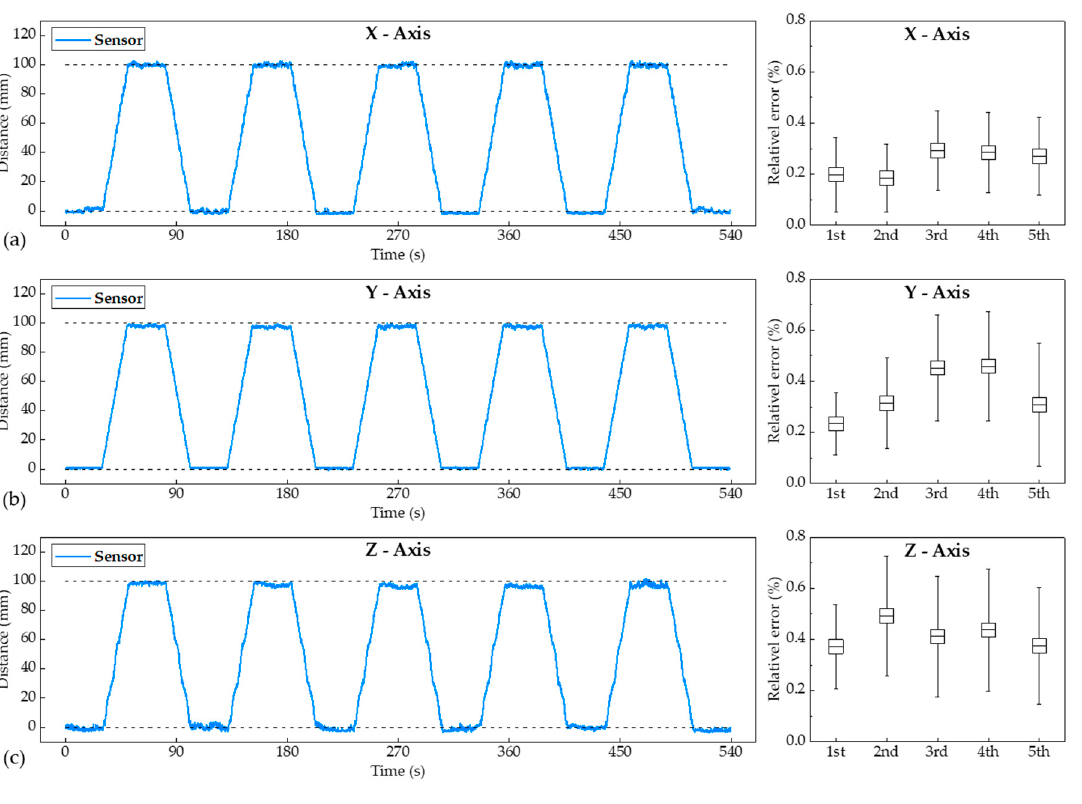
Figure 7. Measured position data and the relative error from the ultrasonic sensors following five cycles of repeated movements along the ( a ) X-, ( b ) Y-, and ( c ) Z-axes.